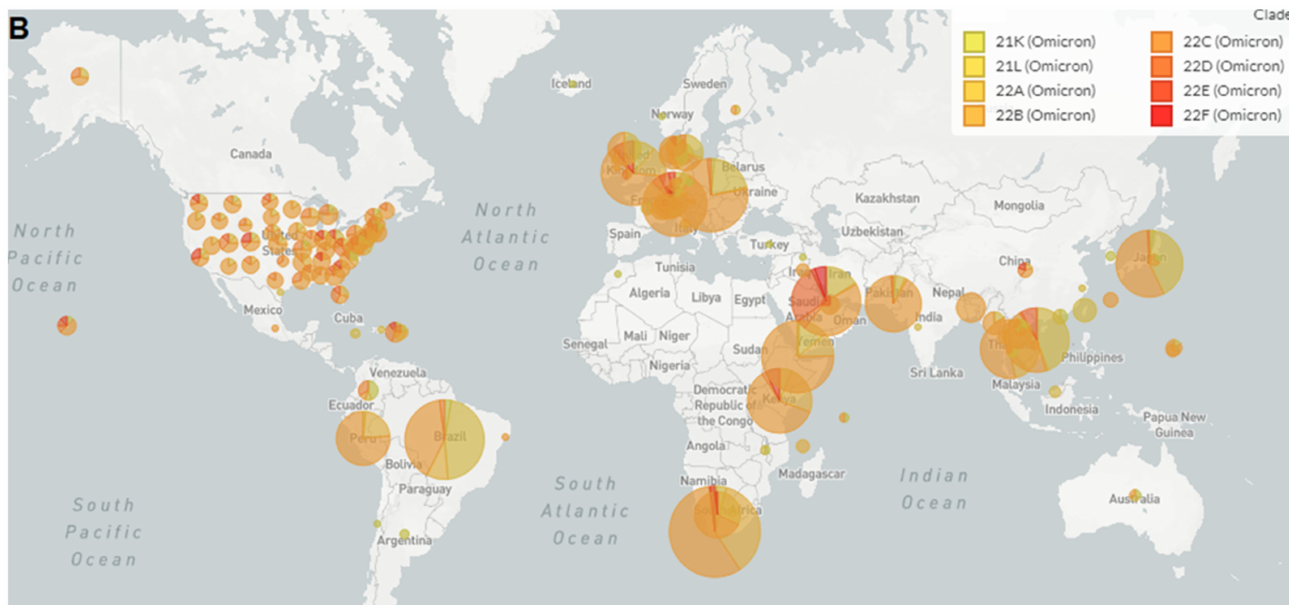
Figure 6. The figure shows the phylogenetic tree of the Omicron and its sub-variants. It also describes the distribution of Omicron and its sub-variants in the entire world. ( A ) The circular phylogenetic tree using the Omicron and its sub-variants ( B ) The distribution of Omicron and its sub-variants. These two figures ( A , B ) were developed using the next strain